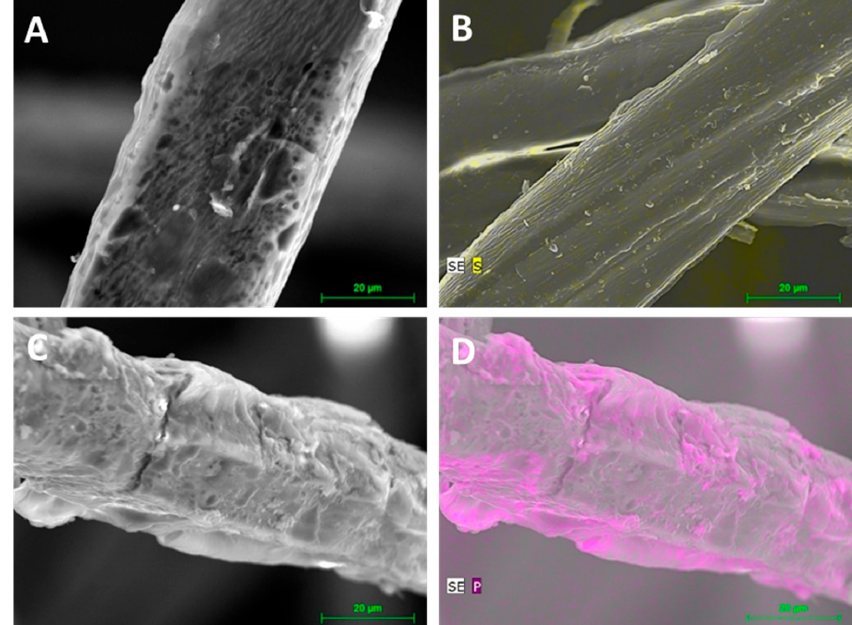
Figure 10. SEM images of untreated wood fibers ( A ), with 10 wt.% commercial flame retardant KF ( B ), with 10 wt.% starch-based flame retardant WS-E ( C , D ), visualization of the element distribution S and P by EDX in yellow and violet ( B , D ), recordings by Björn Günther using JEOL JSM-T330A. The images using energy dispersive X-ray spectroscopy (EDX) document a very homogeneous distribution of the sulfur containing industrial FR on the fiber. However, the starch FR lies on the fiber, enclosing it like a shell. The visualization by EDX shows areas with more intense color, which indicates a partially higher phosphorus concentration and less homogeneity. The recovery was determined by measuring the phosphorus content of the produced insulating material divided by the expected phosphorus content after the application of the FR on the wood fiber multiplied by hundred. The recovery rate was only 53 ± 0.05 wt.% with generally good reproducibility. The losses of flame retardants can have several causes. Losses due to rinsing and sticking to pipes and vessel